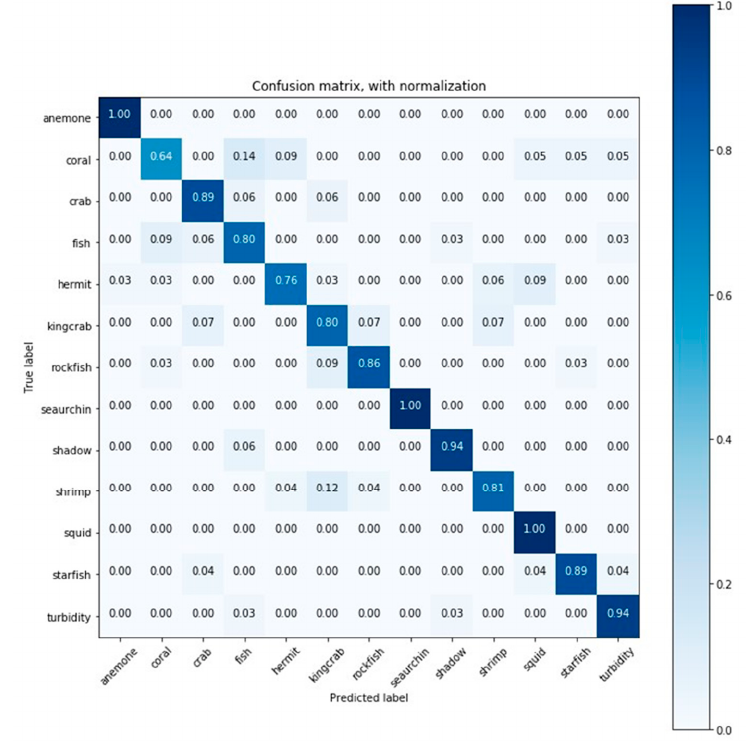
Figure 5. Confusion matrix for the classification results (accuracy) obtained by random forest (RF) RF-2.